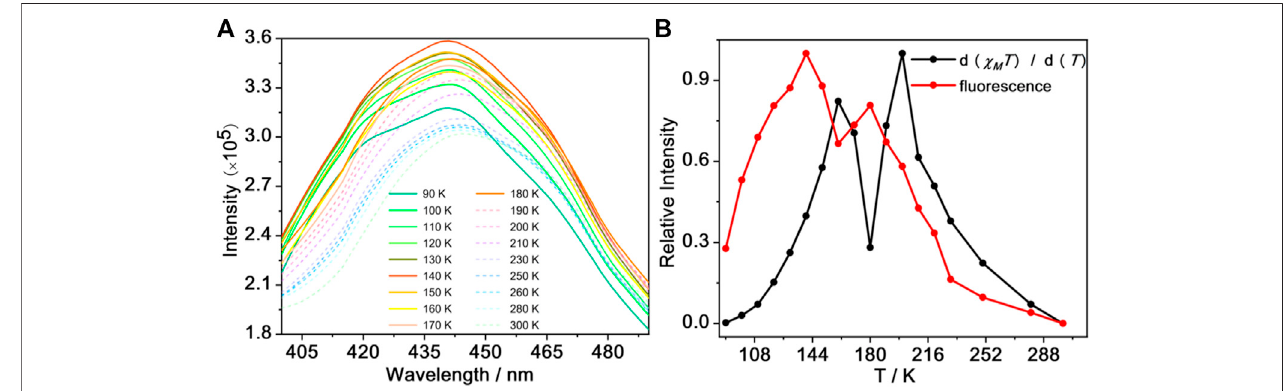
FIGURE5| The fl uorescencespectrafor 1 overthetemperature range90 – 300 K (A) andthe d ( χ M T)/ d (T)curve(blackline)and fl uorescence normalized curve (red line) for 1 (B) .